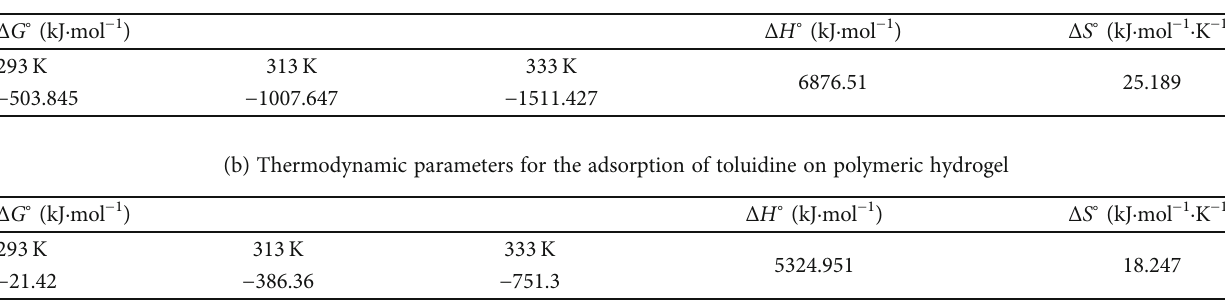
Figure 12: E ff ect of temperature on adsorption of toluidine on GA/AM (adsorbent 0.01, dye solution 10 mL, pH 11, time 60min, temp 293,313, 333K).